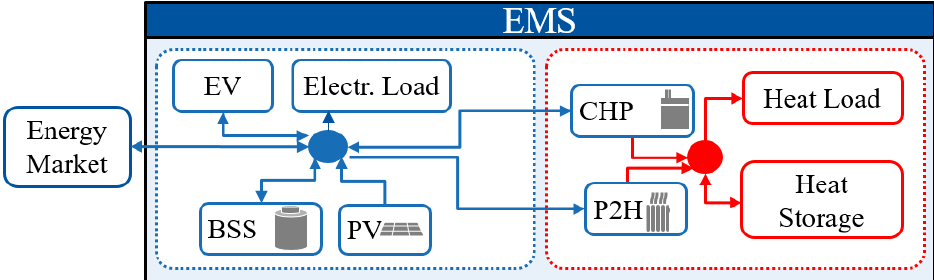
Figure 5. Energy Management System (EMS) model consisting of several